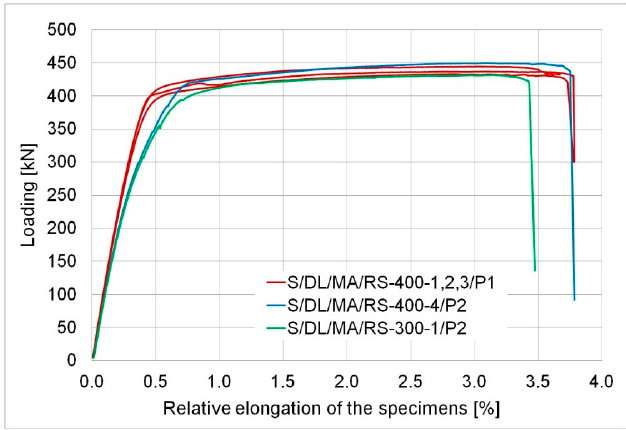
Figure 5. Relationship force—relative elongation of the specimens with the anchor length of 400 mm and 300 mm.